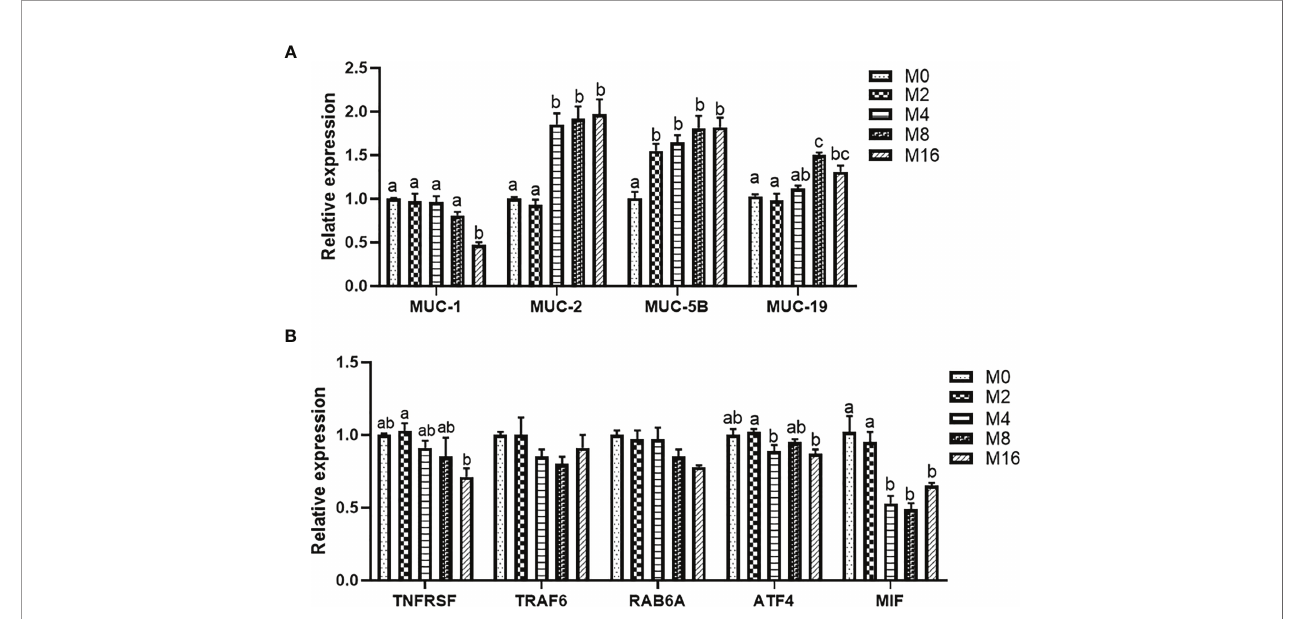
FIGURE 5 | Effects of dietary MOS on the expression of mucin gene (A) and pro-in fl ammatory genes (B) in intestine of Litopenaeus vannamei . a,b,c Value bars not sharing THE same superscript letter are signi fi cantly different as evaluated by Tukey ’ s test ( p < 0.05). MUC-1, mucin-1; MUC-2, mucin-2; MUC-5B, mucin-5B; MUC- 19, mucin-19; TNFRSR, tumor necrosis factor receptor superfamily; TRAF6, tumor necrosis factor receptor-associated factor 6; RAB6A, Ras-associated protein 6A; ATF4, activating transcription factor 4; MIF, macrophage migration inhibitory factor; MOS, mannan oligosaccharide.